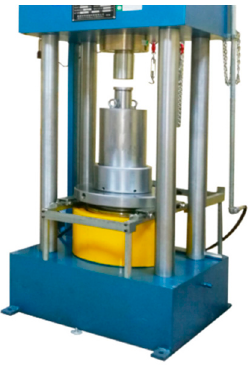
Figure 11. Loading process of specimens.